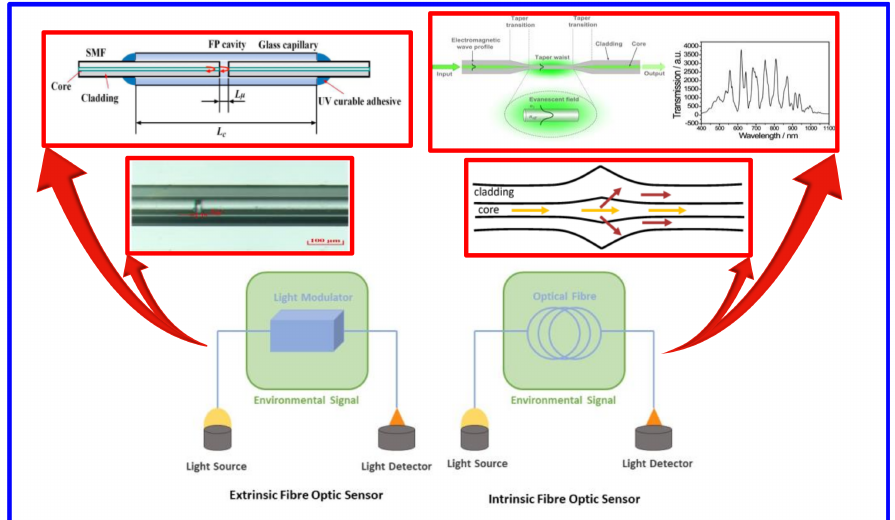
Figure 3. Typical configurations of chemical OFS. Extrinsic sensors, in which fiber is used to direct light and intrinsic sensors, in which the sensor phase modifies the transmission characteristics of the fiber. The sensor membrane can be placed on the tip of the fiber or to the side; part of the coating can be removed and leave the fiber core exposed to the chemical interaction medium